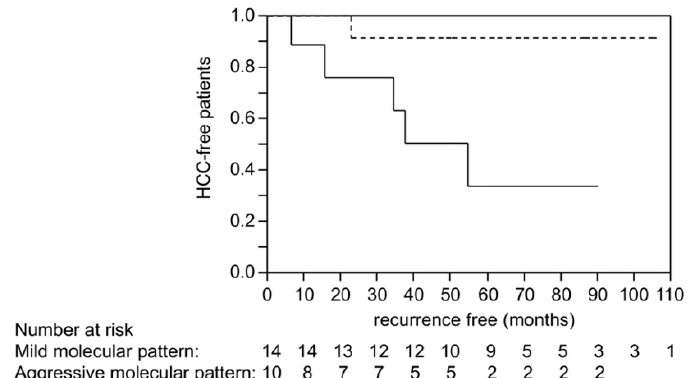
Figure 3. Recurrence-free survival of HCC patients who underwent liver transplantation. The solid line represents the survival of cases with the aggressive molecular pattern (molecular risk factors ≥ 3), and the broken line represents the cases with mild molecular pattern (molecular risk factors ≤ 2). p = 0.0090 by log-rank test.